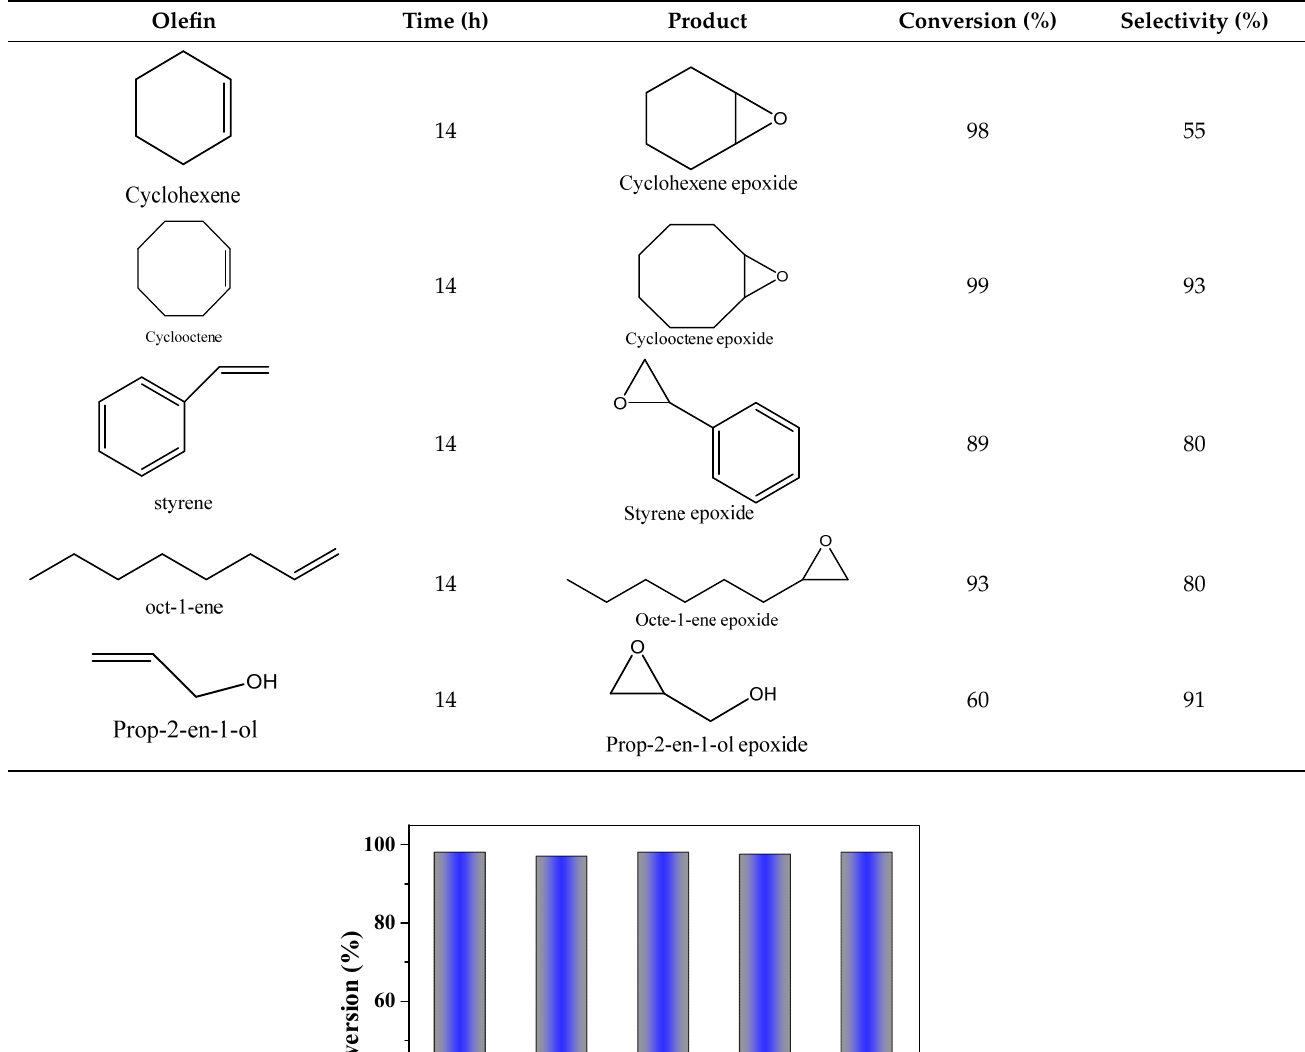
Table 2. Substrates scope of olefins for the epoxidation reaction catalyzed by 10% Ni@CSs (50 mg catalyst, 353 K, pH = 8, and 14 h).